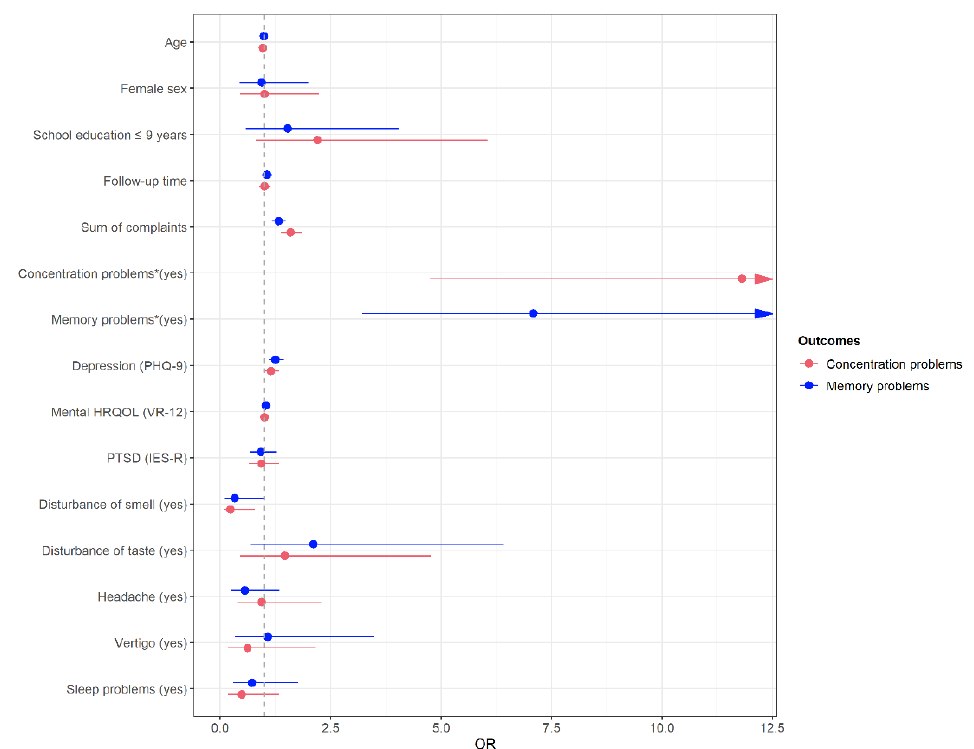
Figure 2. Multivariable logistic regression models for the dependent variables concentration problems and memory problems at follow-up. Odds Ratios (OR) and 95% confidence intervals. Similarly, the presence of memory problems in the COVID-19 acute phase was the main predictor of memory problems at FU (OR = 7.09, p < 0.0001), and more complaints (OR = 1.32, p < 0.0001) as well as higher depression scores (OR = 1.25, p = 0.0010) were significantly associated with self-reported memory problems.